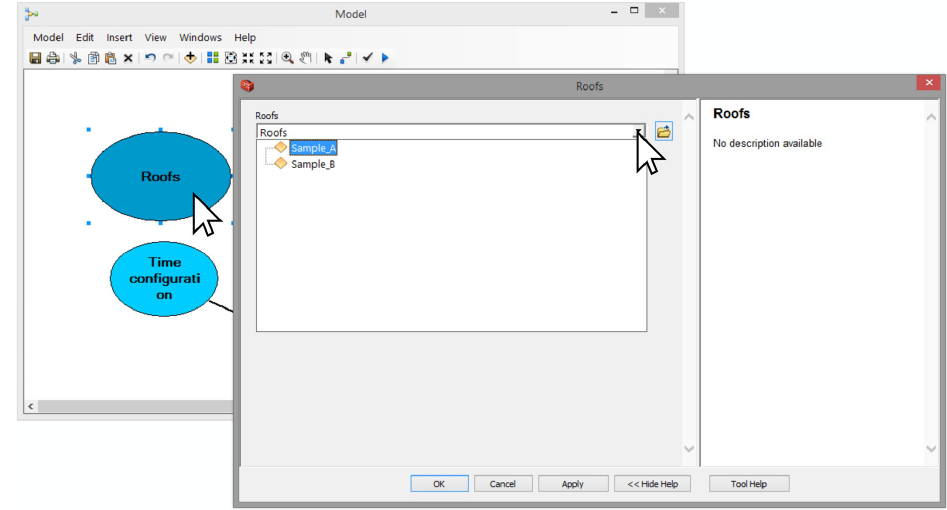
Figure 2. SOLIS interface: input data panel.